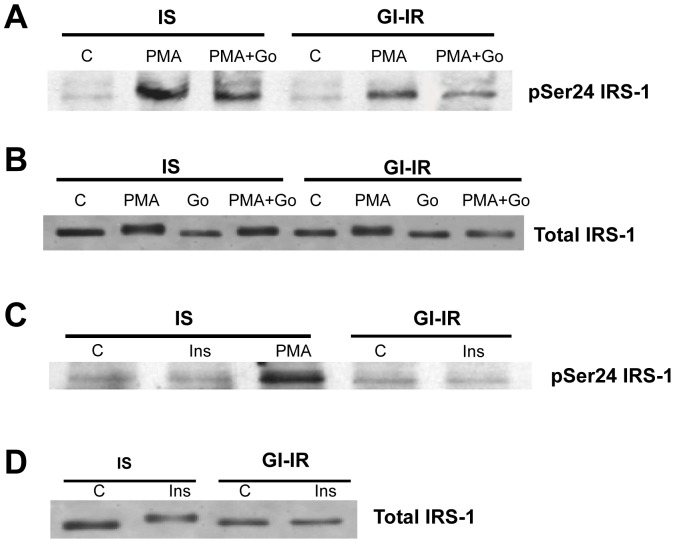
Hyperglycemia-induced insulin resistance does not promote pSer24 IRS-1, a target of cPKC.Adipocytes were preincubated for 18 h in 5 mM glucose (IS) or in 25 mM glucose+0.6 nM insulin (GI-IR). A and B. During the last hour, cells were exposed to either vehicle control (C), PMA (1 mM), Go-6976 (1 mM) or both. IRS-1 was immunoprecipitated from subsequent cell extracts and following gel separation western blotted with an anti-pSer 24 IRS1 (A) or anti-IRS1 (B), as described in Methods. C. pSer 24 IRS1 levels are unaffected by preincubation treatment and acute insulin stimulation. D. Total IRS1 protein exhibit a mobility shift following acute stimulation with 100 nM insulin for 15 min. All gels are representative of 3 similar experiments.